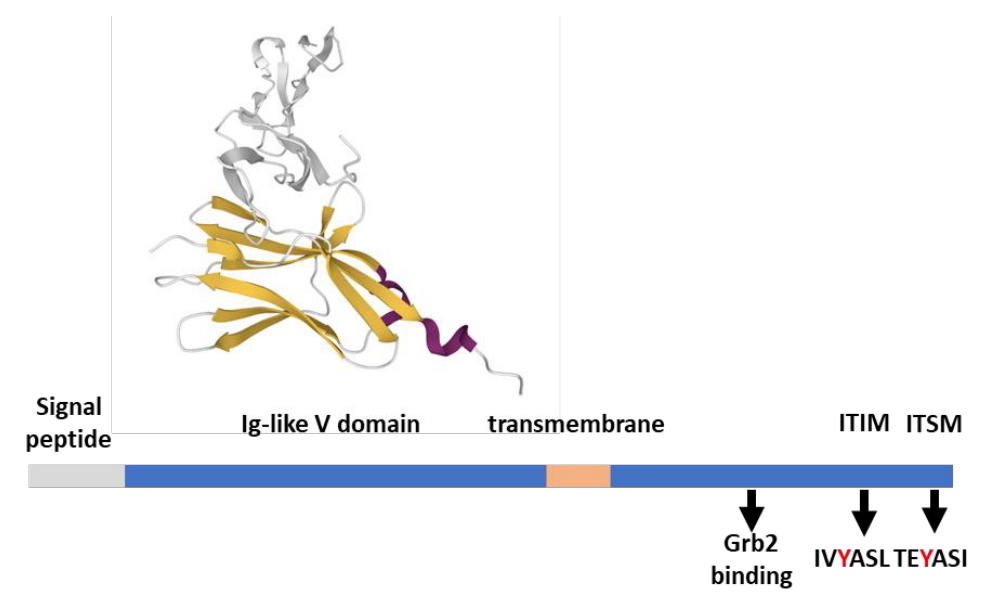
Figure 4. BTLA structural features. BTLA (289 aa) features from the Uniprot database; the ectodomain in complex with HVEM (gray) is 2AW2 [66], rendered by the Mol* application [10].